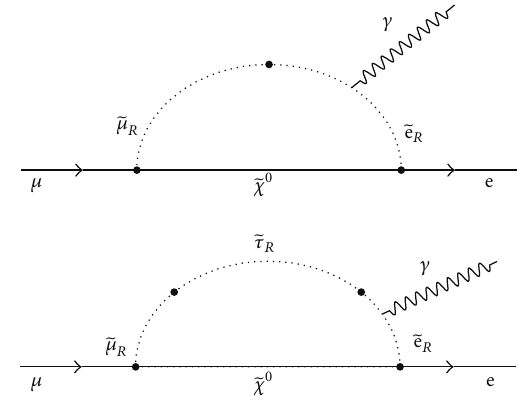
Figure 2: Loop diagrams which induce the 𝜇 → e 𝛾 reaction in SUSY-GUT SU(5) model. The closed blobs represent the flavour transitions due to the off-diagonal terms of the slepton mass matrices [79].